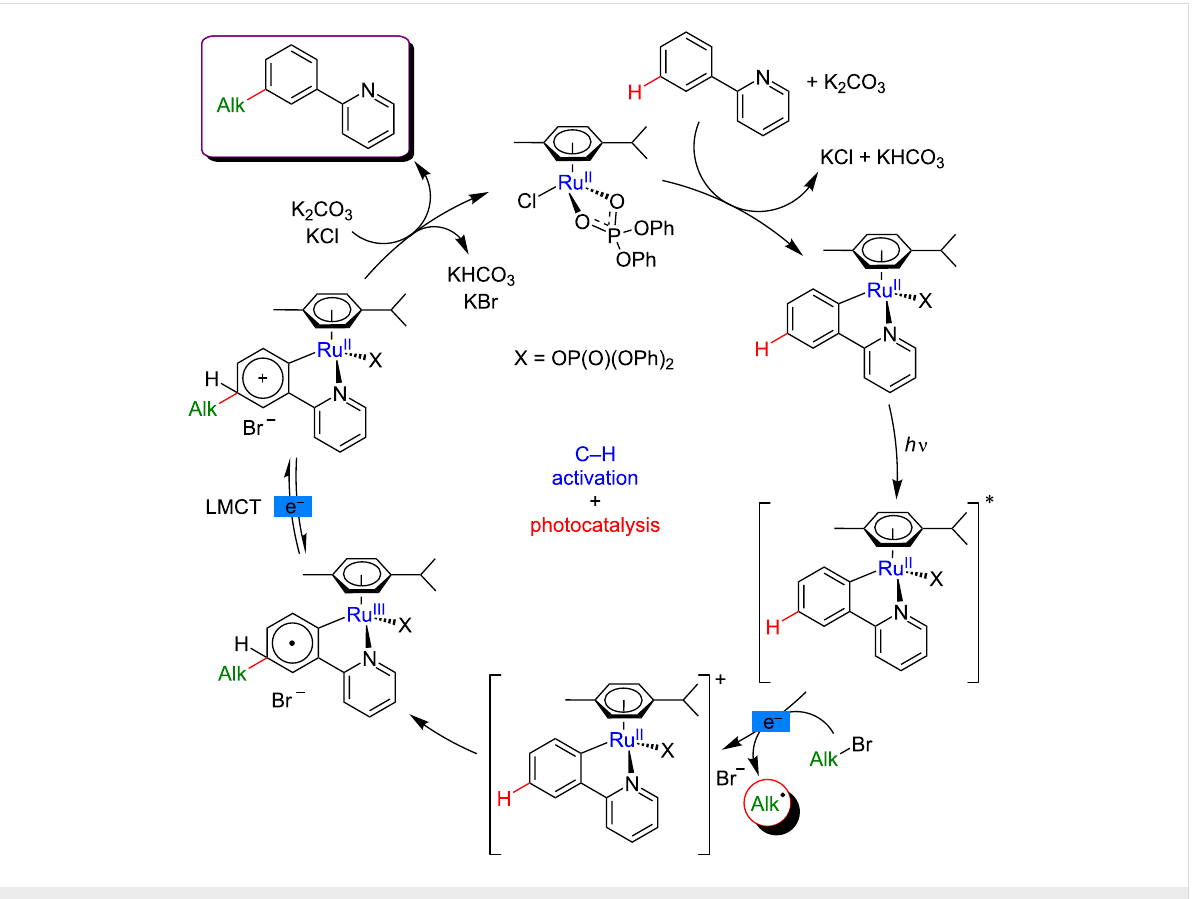
Figure 39: Proposed mechanism for meta -C–H alkylation of arenes via metallaphotocatalysis.